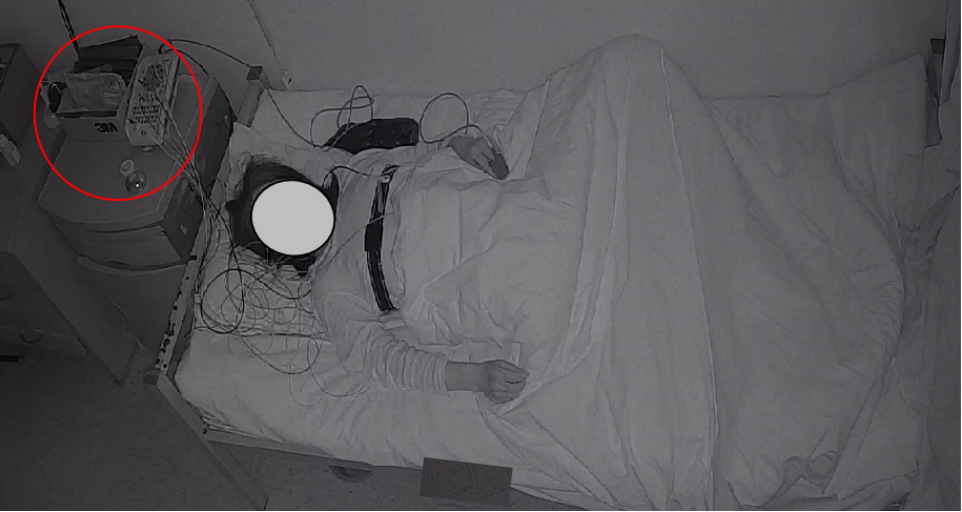
Figure 2. Experimental setting and PSG device. The PSG device is in the red circle on the upper